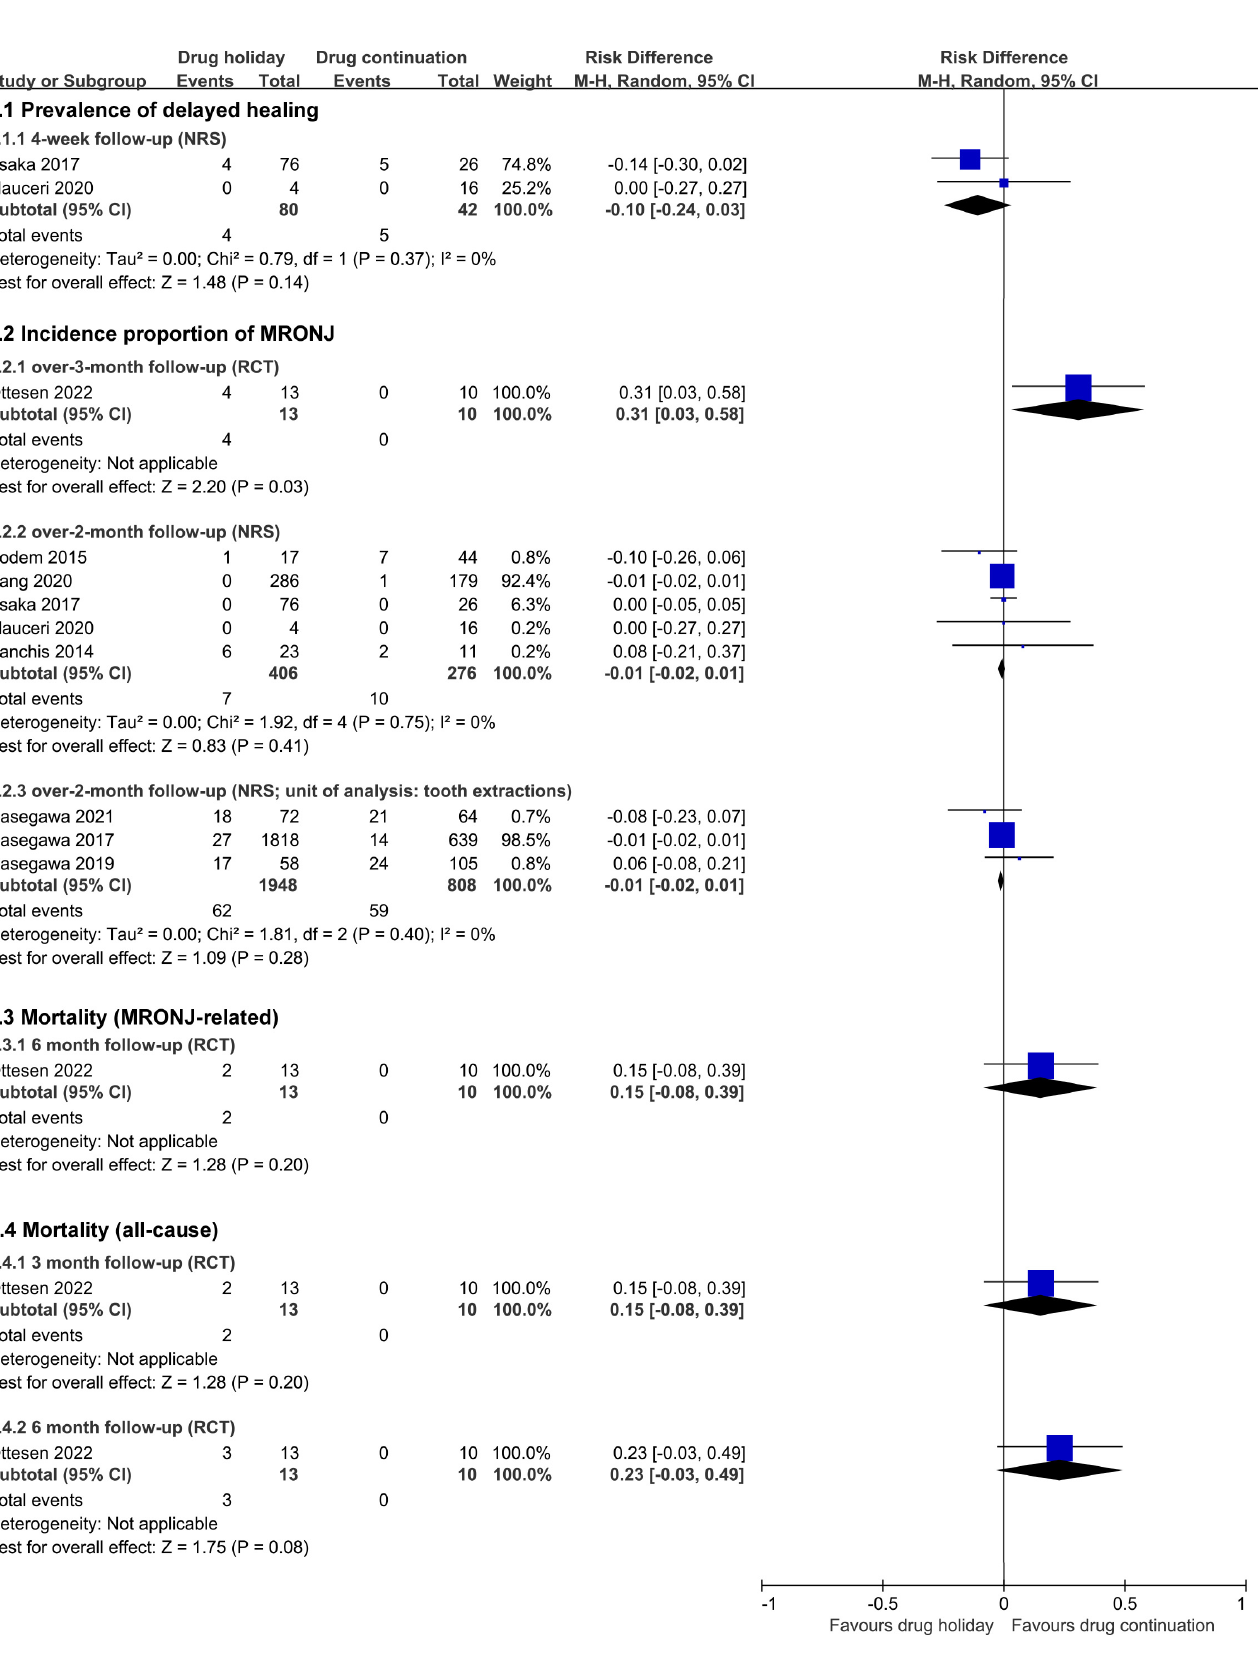
Figure 5. Forest plot of Comparison 1 (drug holiday versus drug continuation) [29,32,33,35–40].